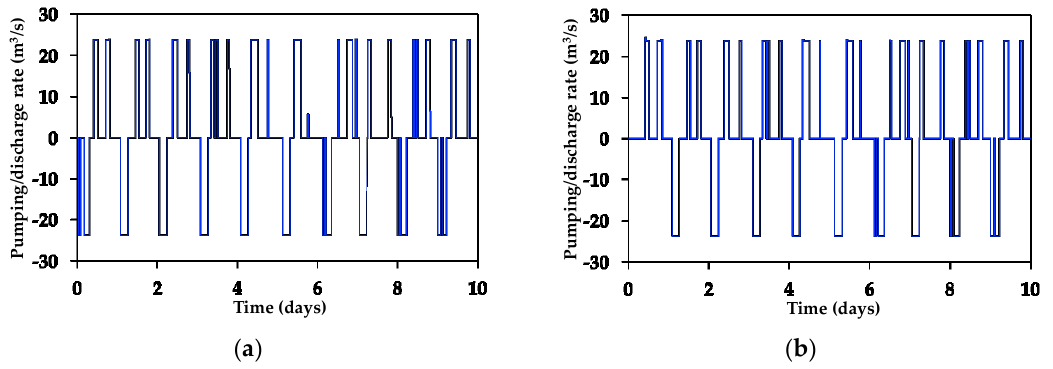
Figure 5. Effective operation scenario for ( a ) scenario F-CI, where the underground reservoir is initially full of water, and ( b ), scenario E-CI where the underground reservoir is initially dewatered.